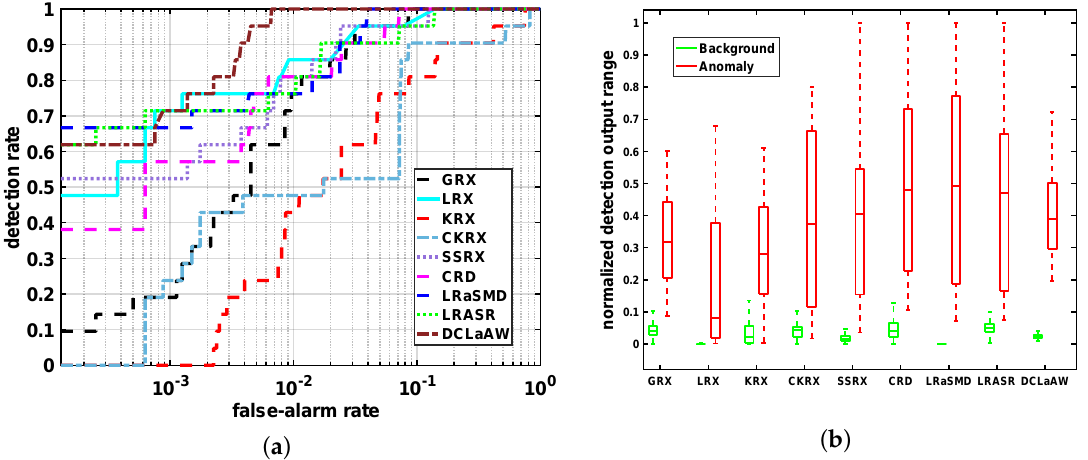
Figure 18. Quantitative comparisons of all compared algorithms for the Urban dataset. ( a ) ROC curves; ( b ) Background-anomaly separation maps.